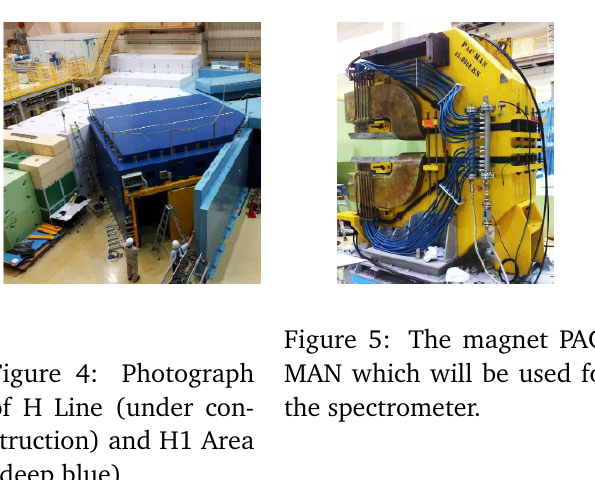
Figure 4: Photograph of H Line (under con- struction) and H1 Area (deep blue).